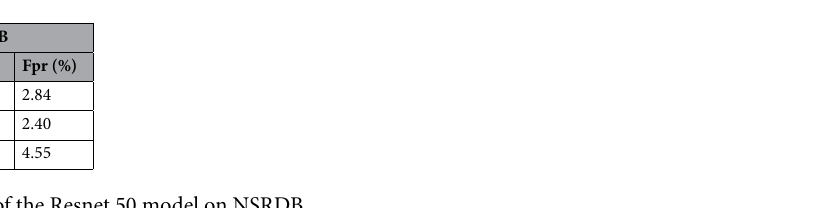
Table 4. Results of the Resnet 50 model on